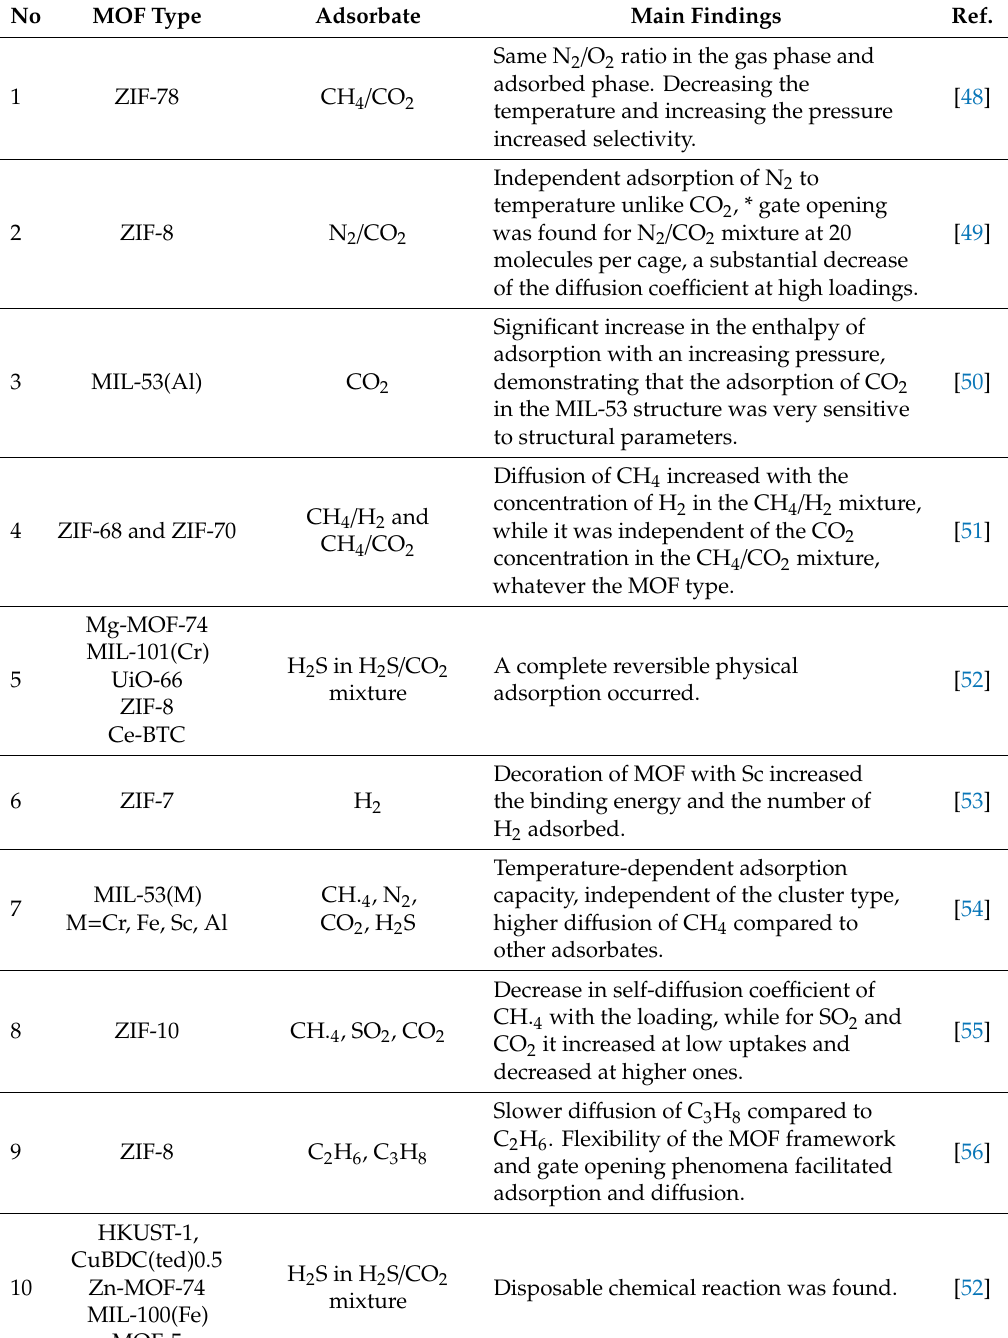
Table 1. Adsorption / di ff usion properties of MOFs from a molecular dynamics perspective. Main Findings